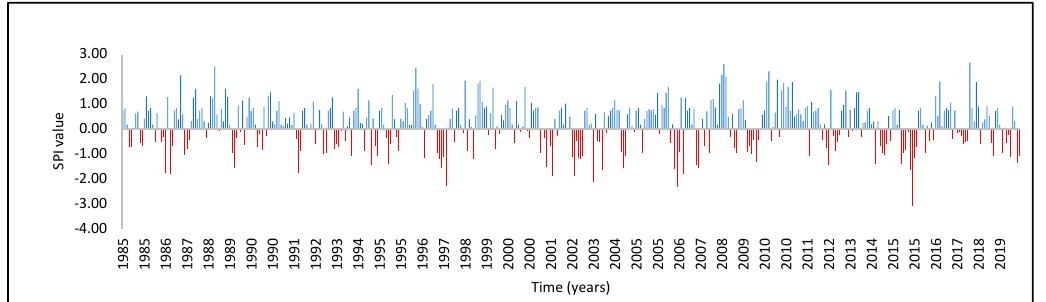
Figure 4. SPI time series, Tolú station in the period (1985–2019).